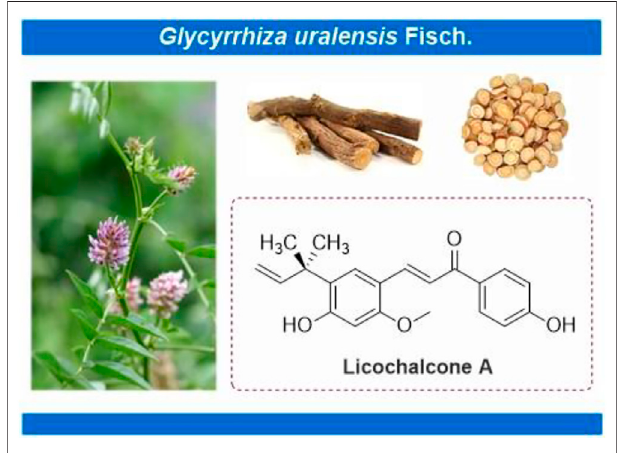
FIGURE 1 | Licochalcone A isolated from Glycyrrhiza uralensis Fisch. ex DC.